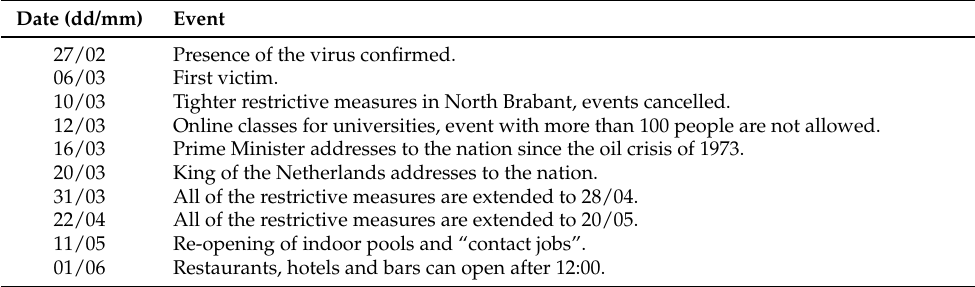
Table 6. Events and policies timeline related to the COVID-19 epidemic situation in The Netherlands.